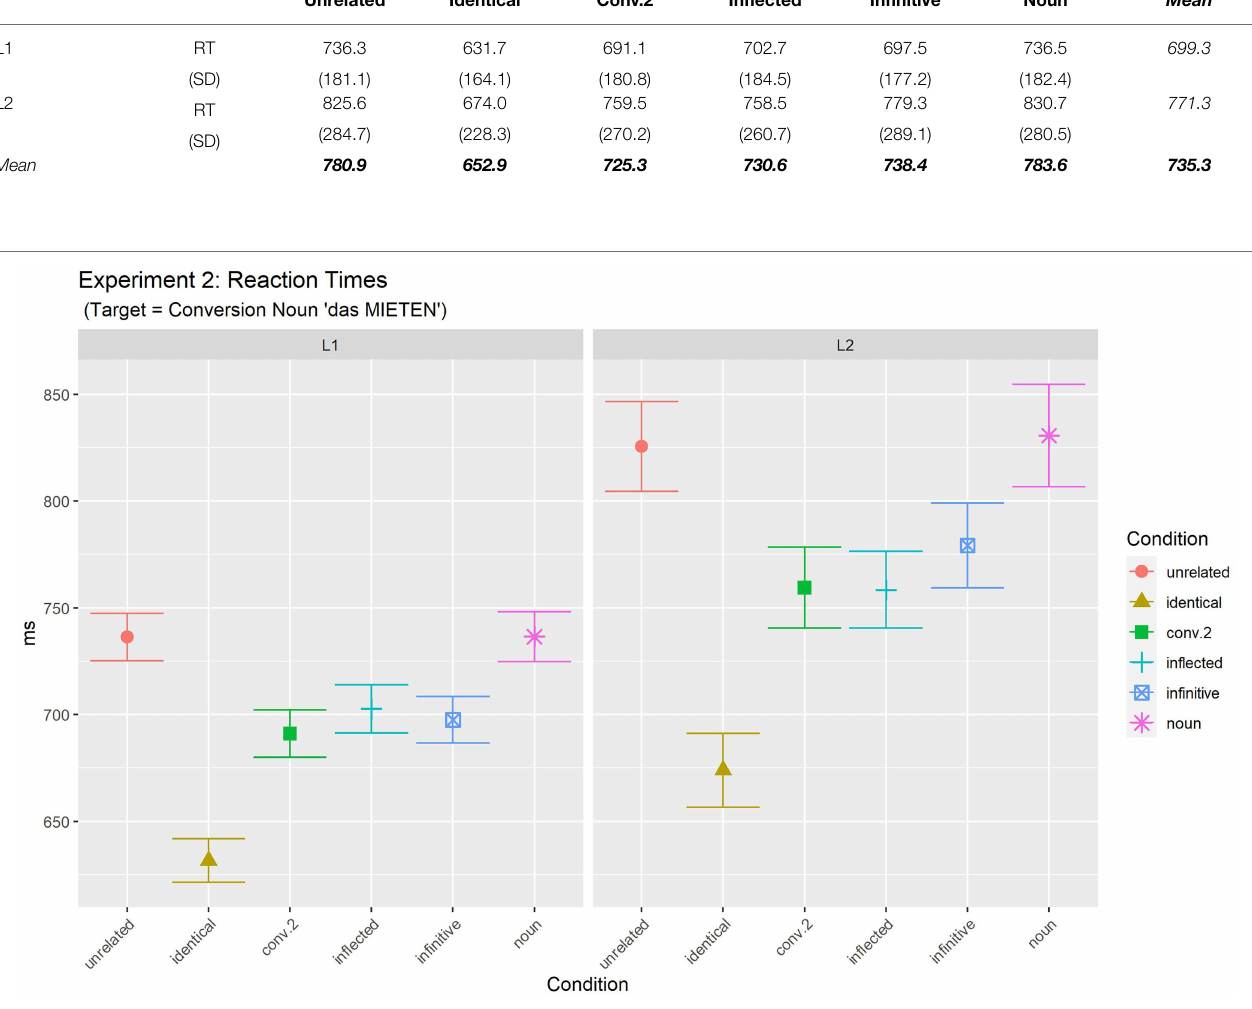
FIGURE 2 | Experiment 2 (target: conversion noun): mean reaction times for target